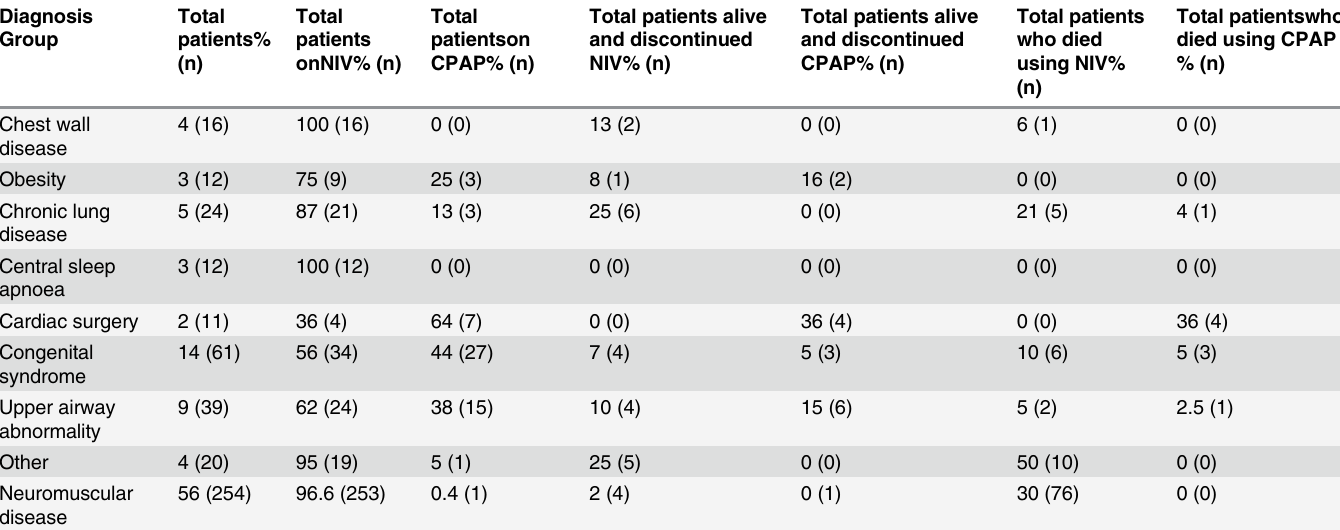
Table 2. Patients under the age of 17 who were commenced and ceased NIV and CPAP by group diagnosis. Diagnosis